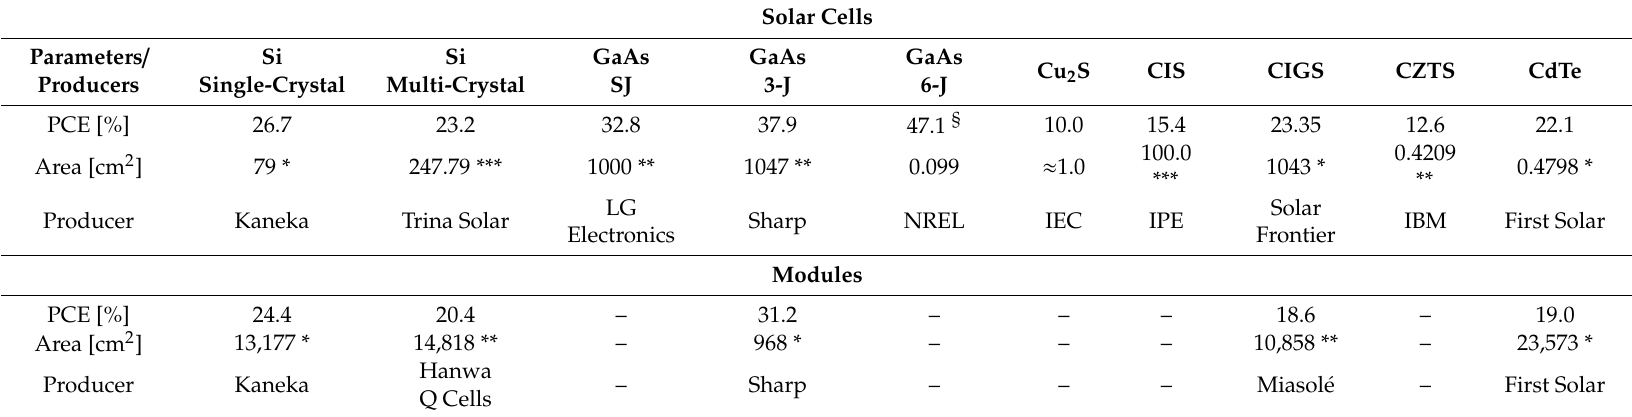
Table 1. Photovoltaic Conversion E ffi ciency (PCE) of the best solar cells and commercial modules collected for di ff erent technologies. The confirmed PCE data are measured under the global AM 1.5 spectrum (1000 W / m 2 ) at 25 ◦ C (IEC 60904-3: 2008, ASTM G-173-03 global). Data reported from [3] and